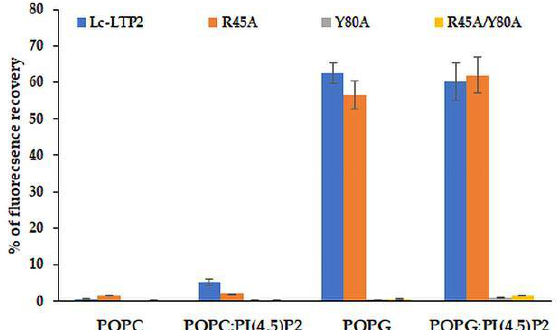
Figure 5. Percentage of calcein dye leakage from small unilamellar vesicle (SUVs) composed of POPC; POPG; and POPC:PI(4,5)P2 (at a 98:2 molar ratio); and POPG:PI(4,5)P2 (at a 98:2 molar ratio) upon addition of Lc-LTP2 and its mutant analogs. All proteins were used at a concentration of 20 μM. Each experiment was performed in triplicate. The results are expressed as the mean values (±SD) of the percentage of the fluorescence using the SUVs + Triton X-100 as a control.